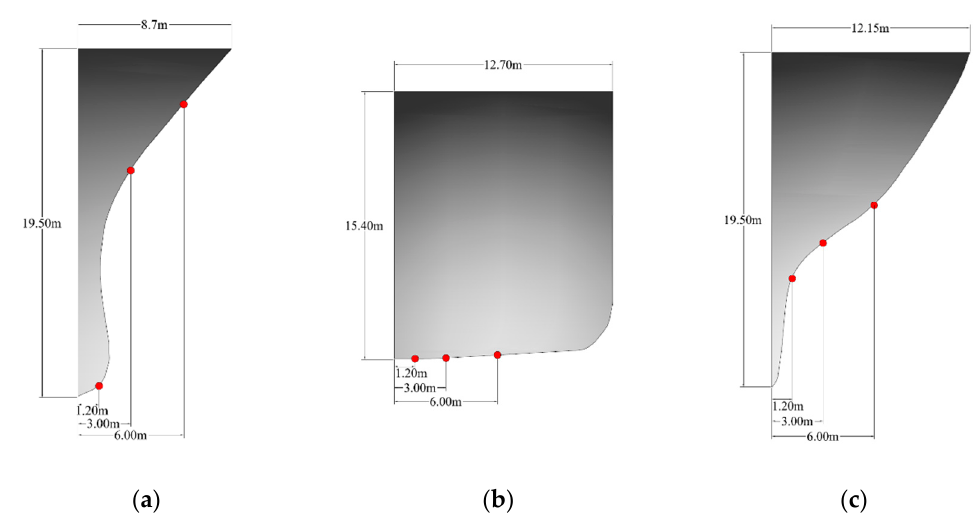
Figure 7. Ship section models: ( a ) Bow; ( b ) parallel middle body; ( c ) stern.